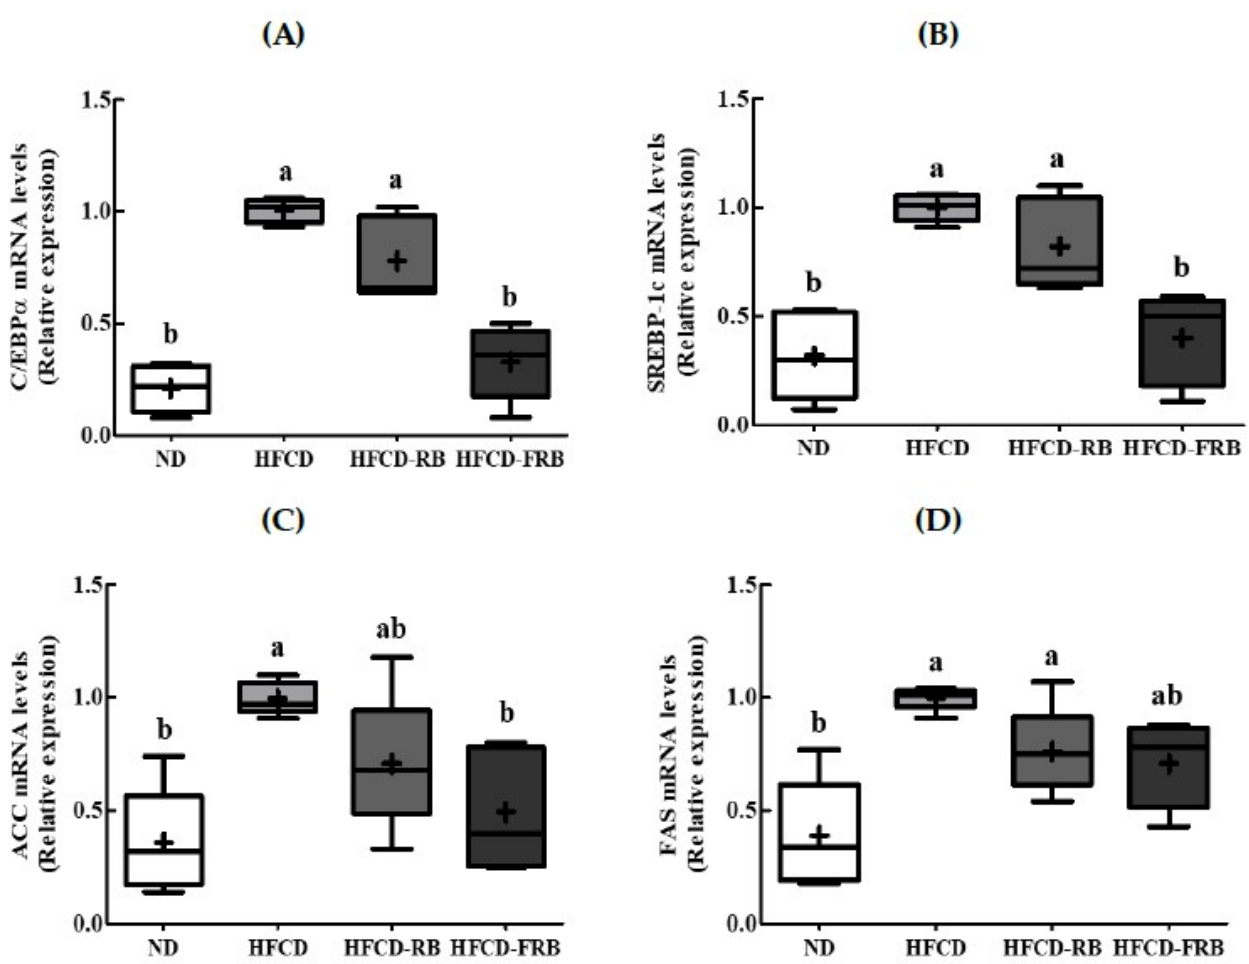
Figure 7. Hepatic mRNA expression in mice fed experimental diets for 10 weeks. Diet groupsL ND, normal diet group; HFCD, high-fat and -cholesterol diet group; HFD-RB, HFCD + non-fermented rice bran powder group; HFCD-FCA, HFCD + fermented rice bran powder group. ( A ) CCAT-enhancer-binding protein-alpha (C/EBP α ), ( B ) sterol regulatory element binding protein-1c (SREBP-1c), ( C ) acetyl-CoA carboxylase ( ACC ), and ( D ) fatty acid synthase (FAS) mRNA expression was analyzed by qRT-PCR and normalized by β -actin. Values are displayed as a Box-and-Whisker plot with means (expressed as ‘+’), n = 10. a,b: bars with different letters are significantly different at p < 0.05 by Tukey’s post hoc test.